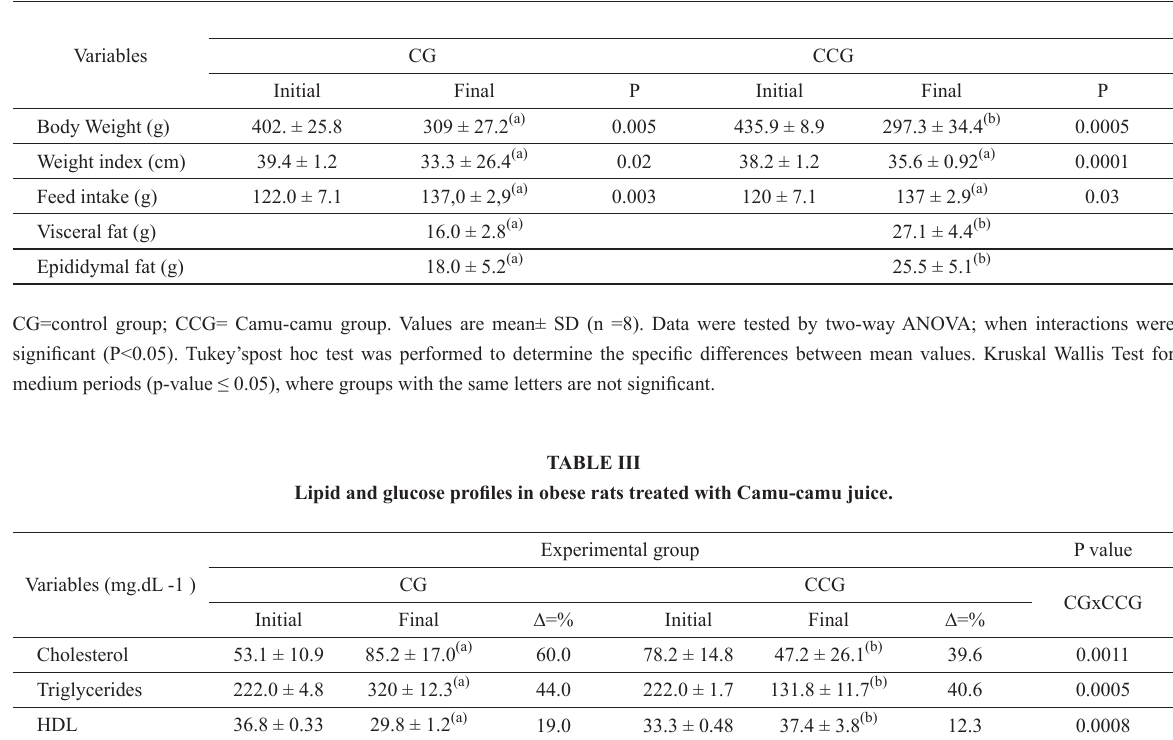
Quantitative analysis of weight-weight of the heart, liver, visceral fat, epididymal fat, index of Lee, feces, liver and heart in obese rats treated with Camu-camu juice.